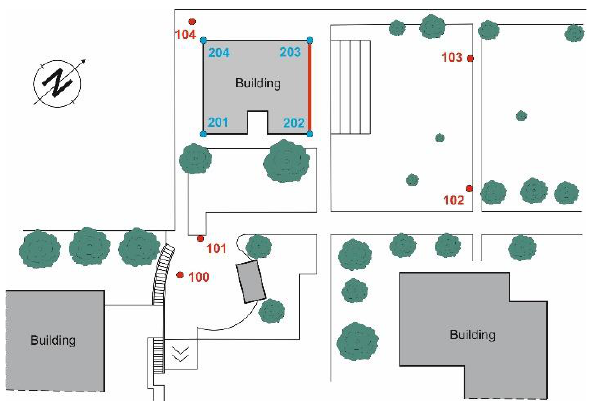
Figure 2 . An overview of the test site: the five accessible topographic points are shown in red, whereas the four building corners are highlighted in blue. The façade where are the check Table 1 . Consistency of measurements acquired in Scenario points is highlighted in red. Façade points are not visible here, but are shown in Figure 3